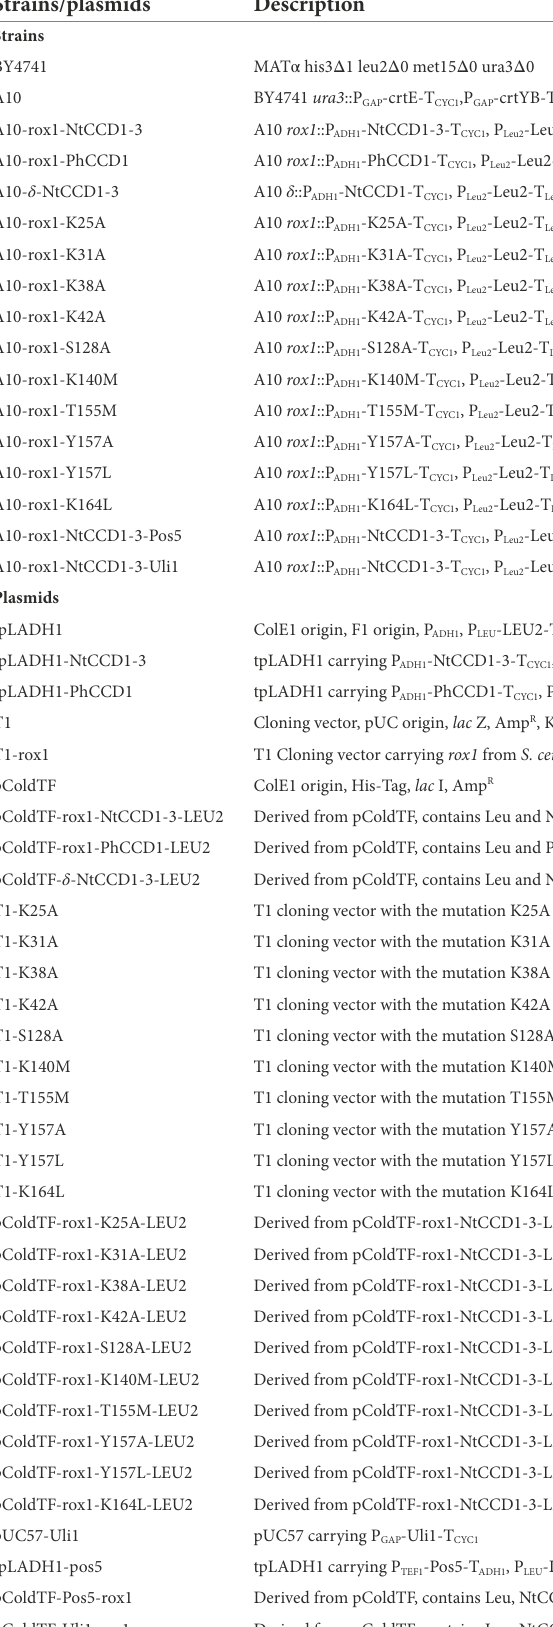
TABLE 1 Strains and plasmids used in this